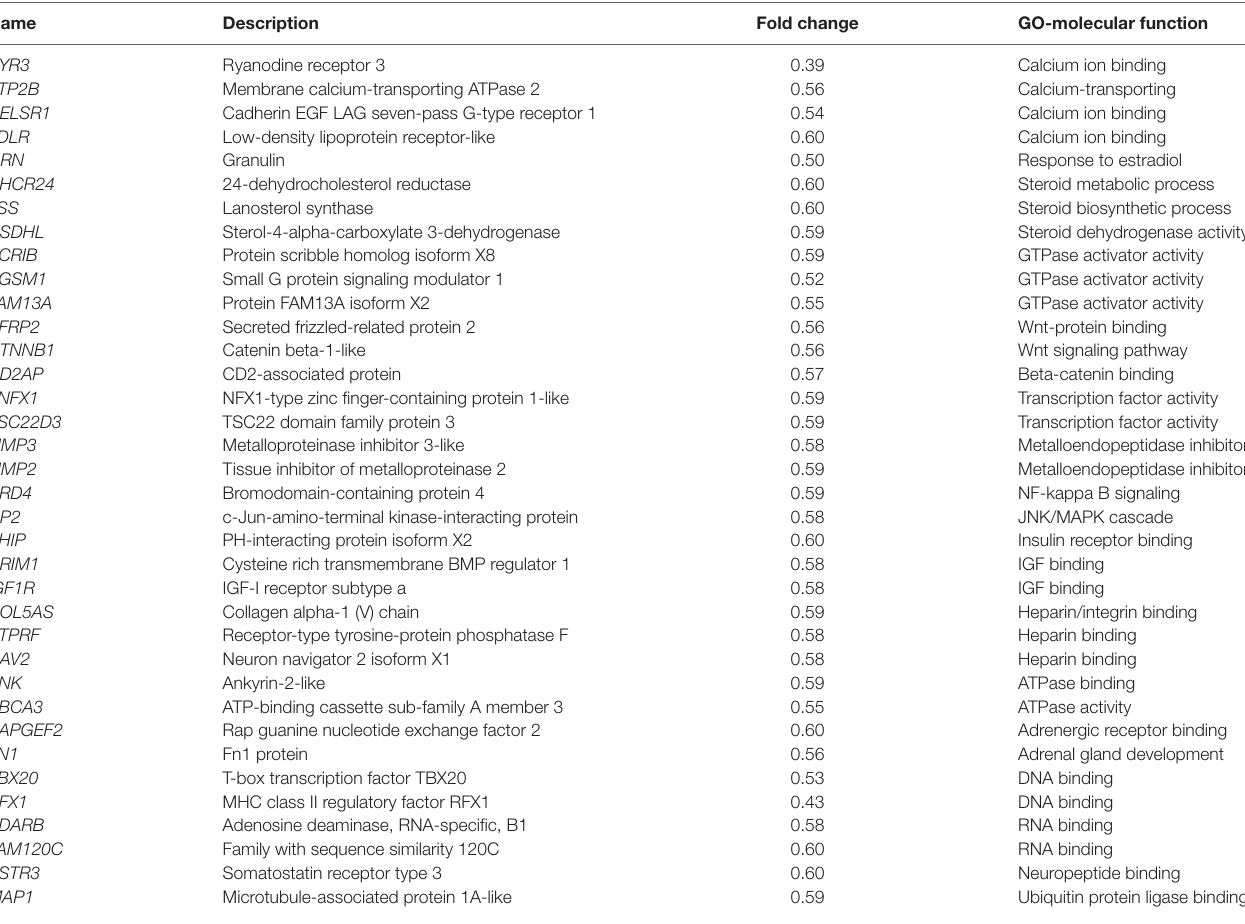
TaBle 2 | Genes downregulated by E2 in prepubertal grass carp pituitary